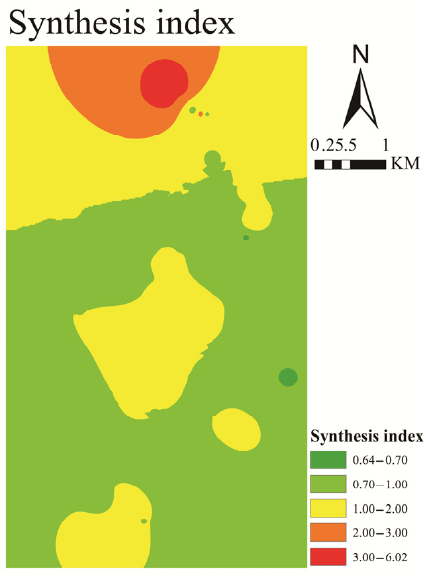
Figure 10. The synthesis index map of metals in study area.